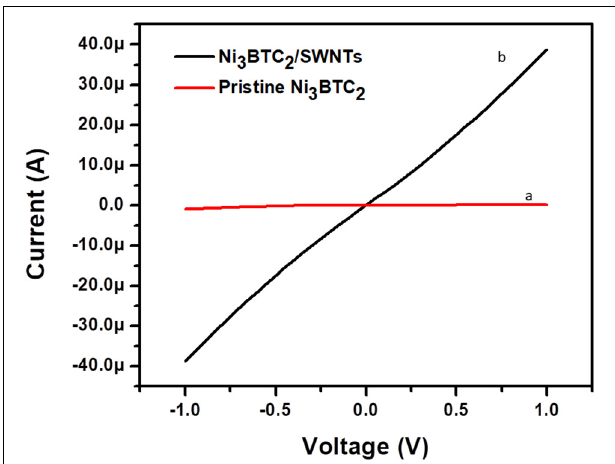
FIGURE 5 | Electrical (I-V) characteristics of (a) pristine Ni 3 BTC 2 and (b) composite of Ni 3 BTC 2 /OH-SWNTs.